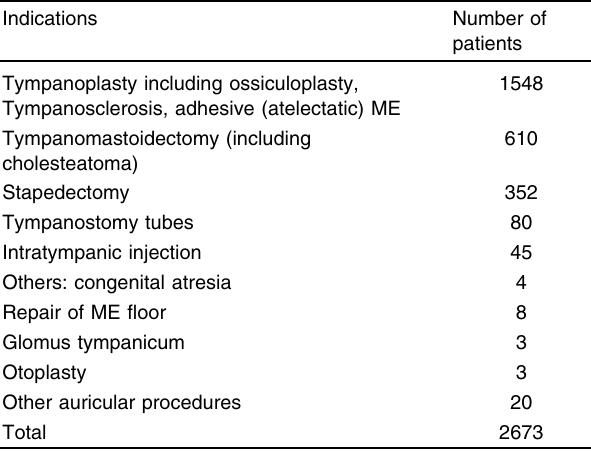
Table 1 Indications and number of patients operated upon under local anesthesia Indications Number of